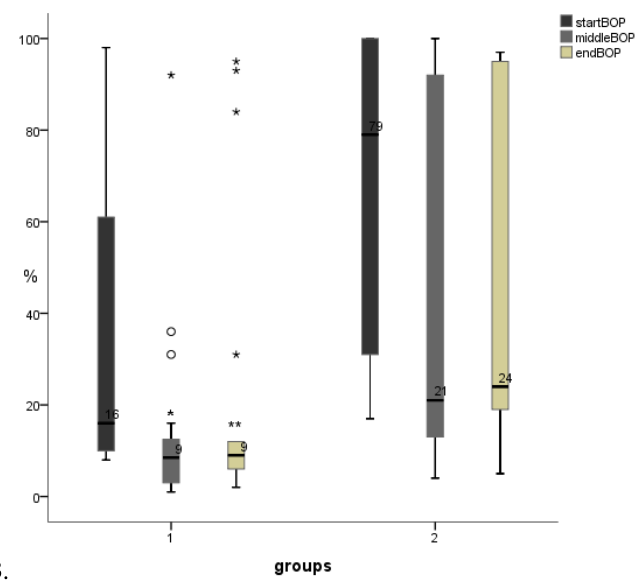
B . B . Figure 2. Boxplots for A . aMMP-8 (ng/mL, PerioSafe ® ) and B . BOP (%). Measuring points for group 1 Figure 2. Boxplots for ( A ). aMMP-8 (ng / mL, PerioSafe ® ) and ( B ). BOP (%). Measuring points (start = 0 days, middle = 14 days, end = 28 days) and group 2 (start = 0 days, middle = 7 days, end = 14 for group 1 (start = 0 days, middle = 14 days, end = 28 days) and group 2 (start = 0 days, days). Decreases/increases of BOPs were compared pairwise: start/middle, start/end. p < 0,001***, p < Figure 2. Boxplots for A . aMMP-8 (ng/mL, PerioSafe ® ) and B . BOP (%). Measuring points for group 1 middle = 7 days, end = 14 days). Decreases / increases of BOPs were compared pairwise: start / middle, 0,01**, p < 0,05* (smaller asterisks). Values more than three interquartile range (IQR) from the end of (start = 0 days, middle = 14 days, end = 28 days) and group 2 (start = 0 days, middle = 7 days, end = 14 start / end. p < 0.001***, p < 0.01**, p < 0.05* (smaller asterisks). Values more than three interquartile a box are labeled as extreme outliers (larger asterisks) and values more than 1.5 but less than 3 IQR’s range (IQR) from the end of a box are labeled as extreme outliers (larger asterisks) and values more days). Decreases/increases of BOPs were compared pairwise: start/middle, start/end. p < 0,001***, p < from the end of a box are labeled (o) outliers. than 1.5 but less than 3 IQR’s from the end of a box are labeled (o) outliers. 0,01**, p < 0,05* (smaller asterisks). Values more than three interquartile range (IQR) from the end of a box are labeled as extreme outliers (larger asterisks) and values more than 1.5 but less than 3 IQR’s The e ff ect on visible plaque index (VPI) is shown in Figure 3. VPI diminished in both groups from the end of a box are labeled (o) outliers. significantly (group 1: p < 0.01, group 2: p < 0.05). PPDs were not a ff ected.